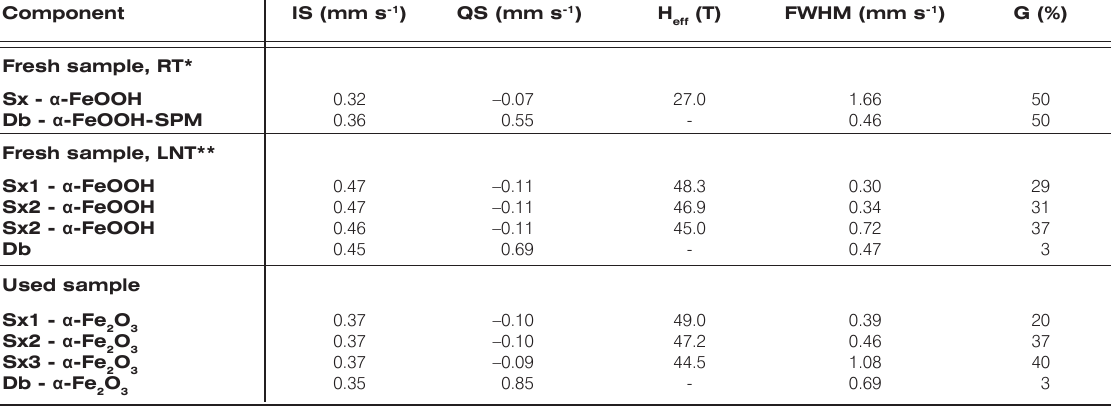
Fig. 4 a. For more detailed characterization of the material far-IR spectrum was also registered (Fig. 3a). A broad band is seen in the spectral region 300–55 0 cm –1 with three maxima at about 370, 415/410 and 460/457 cm –1 .